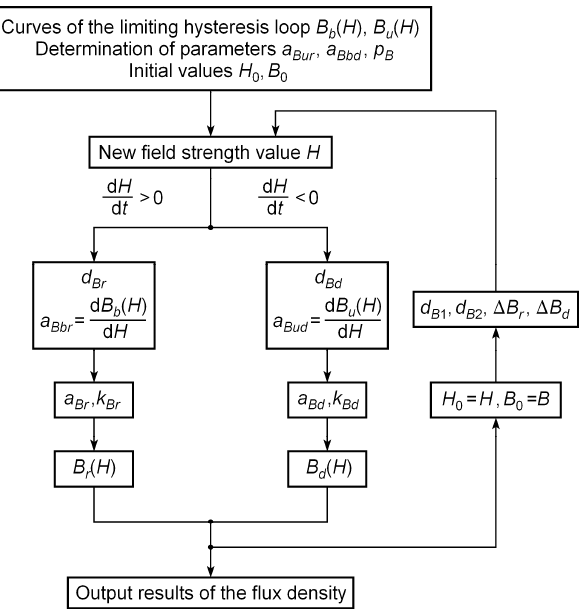
Figure 3. Algorithm to determine changes in the flux density.